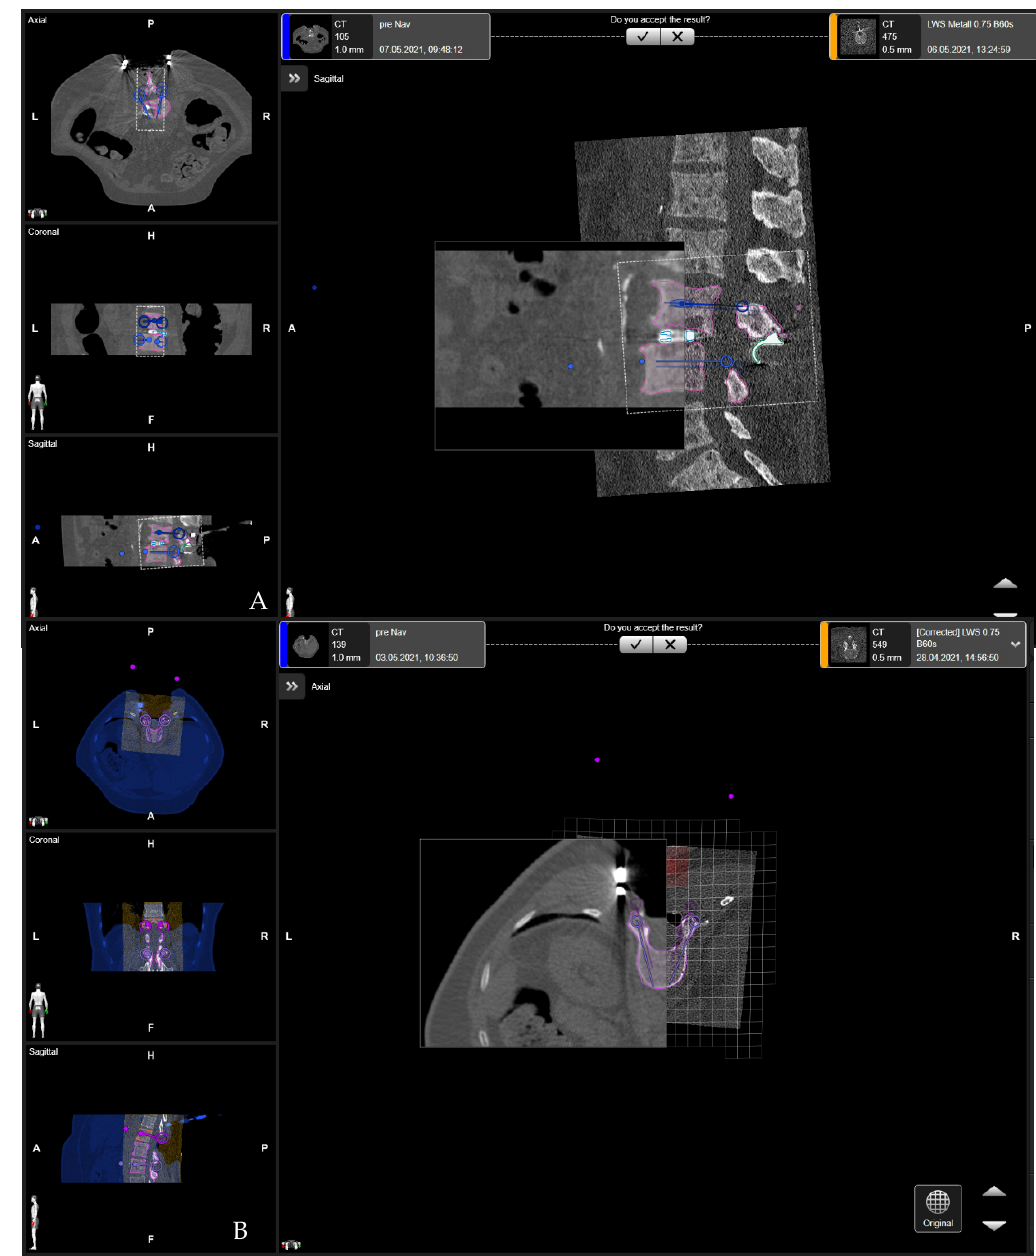
Figure 3. ( A ). Rigid fusion of the preoperative CT of the lumbar spine and registration iCT scan with preplanned screw trajectories (Patient number 3). ( B ). Elastic fusion of the preoperative CT of the lumbar spine and control iCT in the case of multisegmented stabilization in the thoracolumbar spine (Patient number 2.).